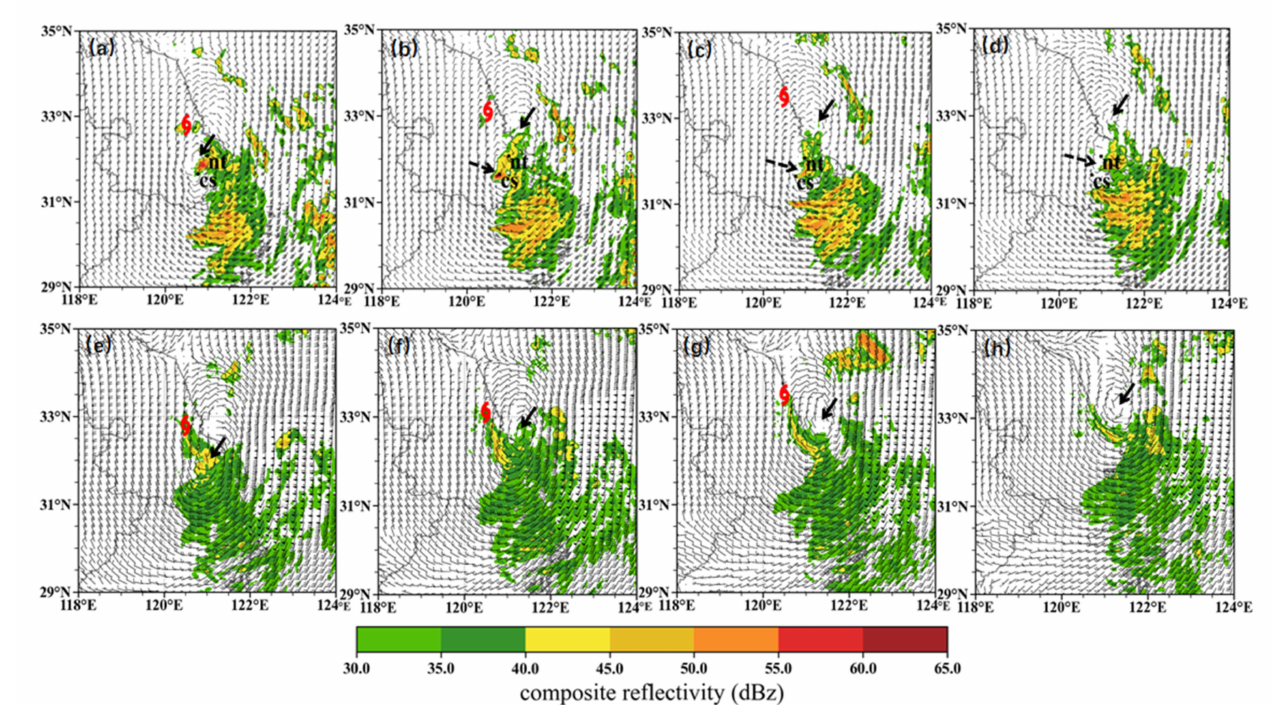
Figure 7. Simulated wind at 500 hPa (black barbs, unit: m s − 1 ) and composite reflectivity (shaded area, unit: dBz) from 03:00 BT to 06:00 BT 5 August 2020; the red symbol is the center position of the typhoon on the ground at the moment, black dot is the city location in China (nt, Nantong.; cs, Changshu), and the arrows are the vortex at 500 hPa (solid line: typhoon center, dotted line: mesoscale vortex) in the figure. ( a – d ) normal simulation, ( e – h ) the simulation after closing the latent